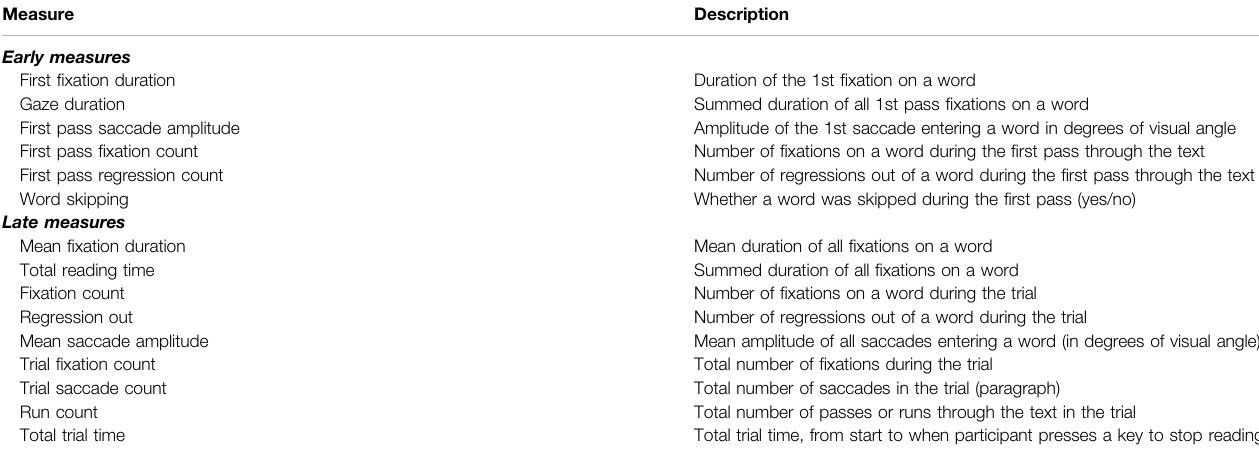
TABLE 4 | De fi nition of eye-tracking